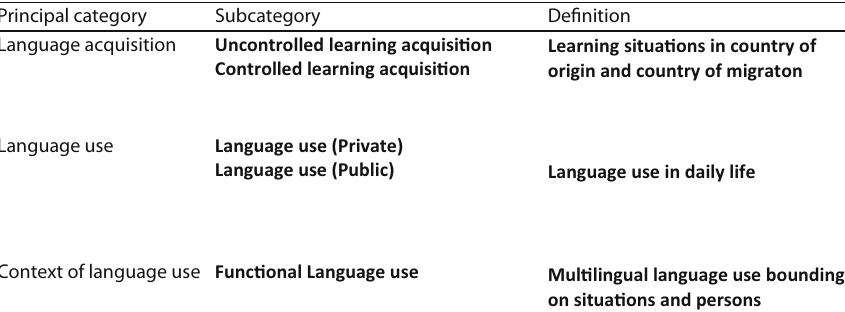
Figure 1: Principal categories, subcategory, and de fi